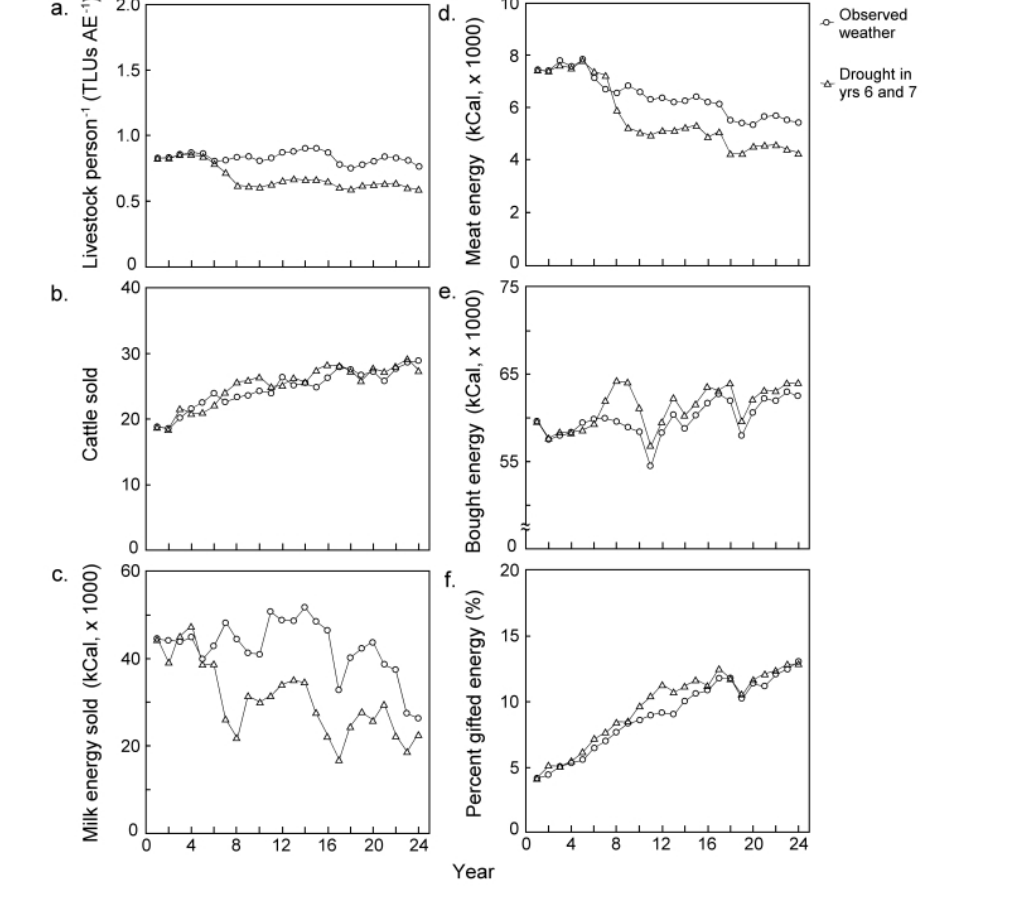
Fig. 4 . Selected DECUMA responses, comparing the baseline simulation with observed weather data (circles) to responses when a 2-yr drought (triangles) ocurred in Years 6 and 7 of the simulation. The responses in panels “b”, “d”, “e”, and “f” are per month, and those in panel “c” are per year. Panel “a” includes standardized measures for livestock and humans, tropical livestock units (TLU, with one unit equal to 250 kg body mass of livestock), and adult equivalents (AE, where adult males were assigned an AE of 1, and adult females and younger people were assigned smaller values) (see Appendix 2 for AEs